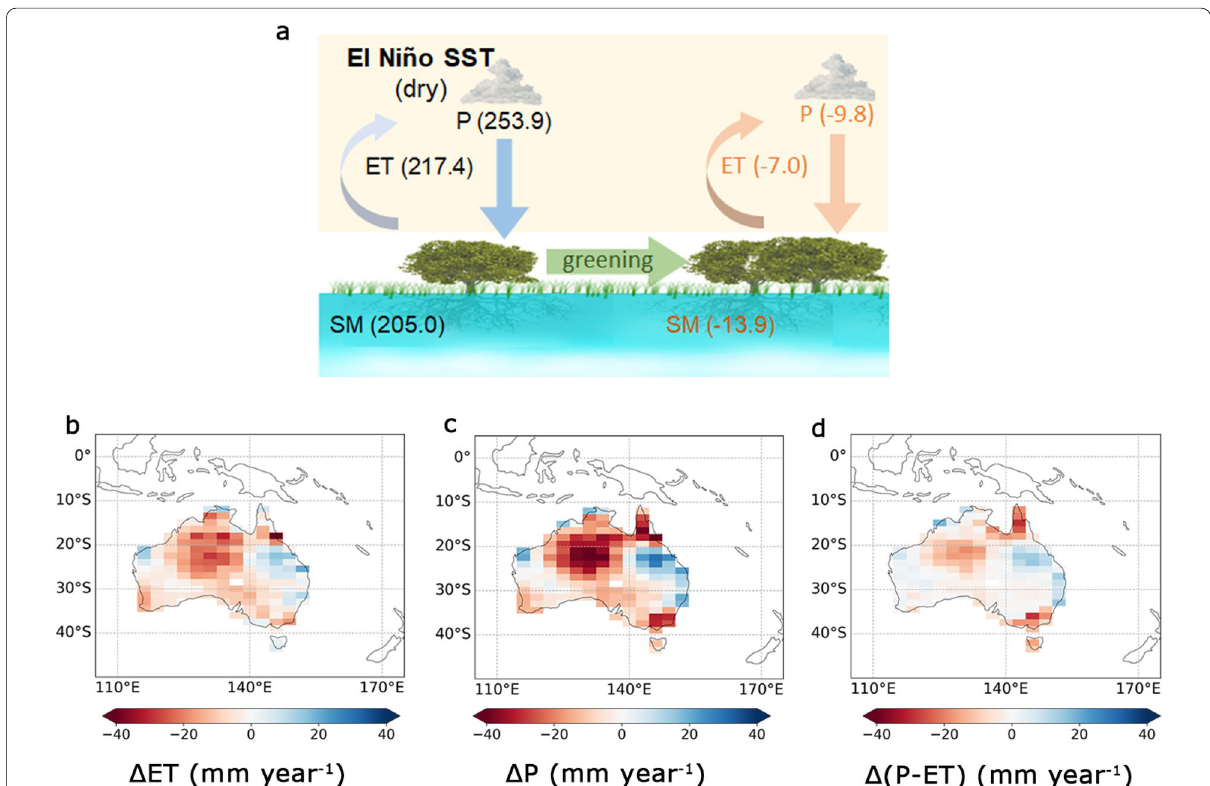
Fig. 6 Conceptual illustration and the spatial patterns of the modeled changes in water yield under greening for El Niño SST forcing. a The biosphere–atmosphere iterations before and after greening for hydrological balance variables ET (mm year − 1 ), precipitation (P, mm year − 1 ), and soil moisture (SM, mm). b – d The spatial patterns of the changes in ET, precipitation (P), and water yield (P-ET) under greening